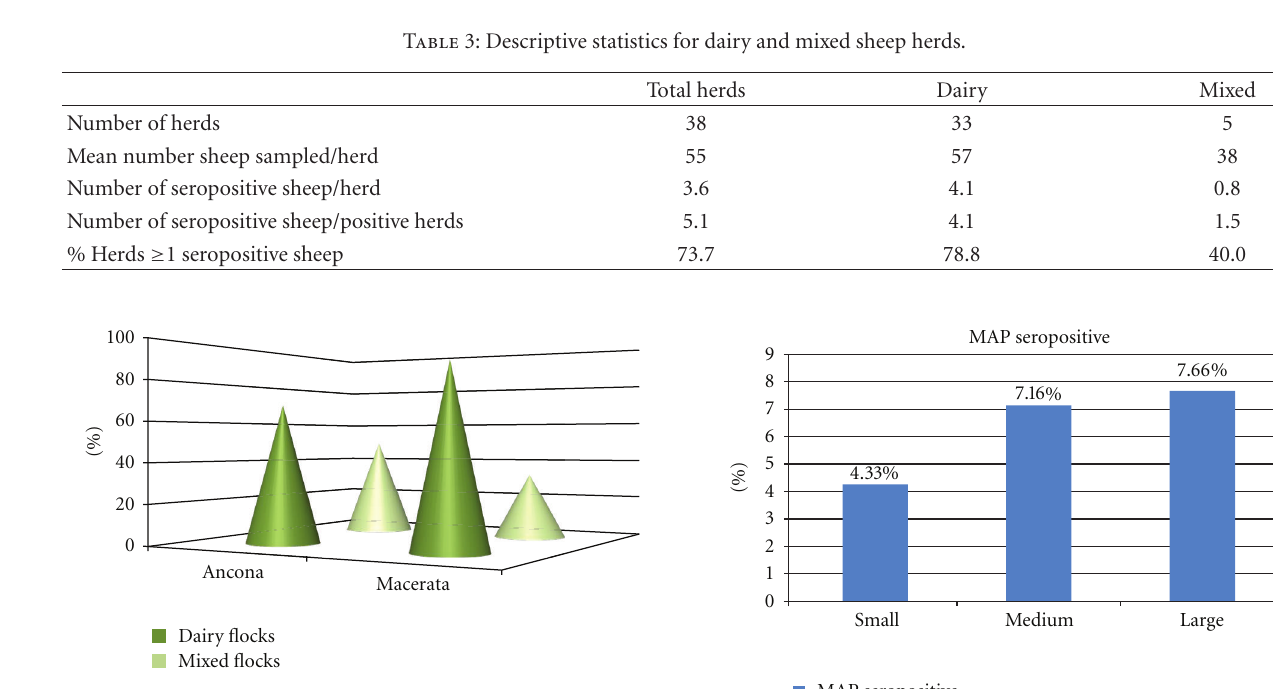
Figure 2: Herd seroprevalence of MAP in dairy and mixed flocks of Ancona and Macerata provinces.